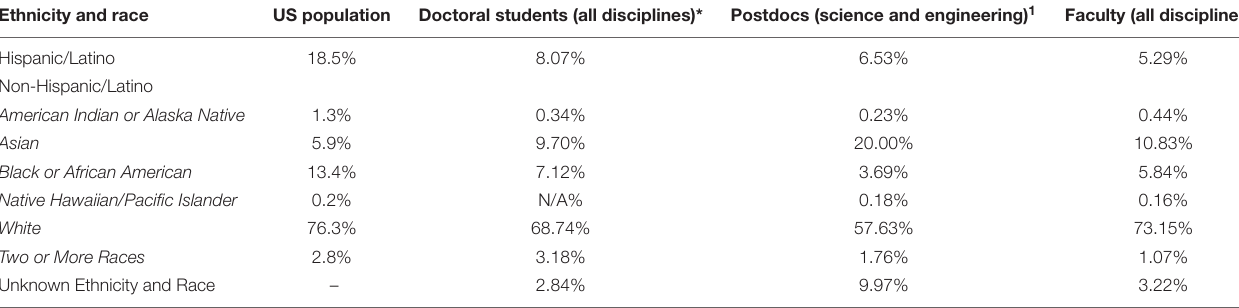
TABLE 1 | Percent distribution of graduate students, postdocs and faculty by race and ethnicity. Ethnicity and